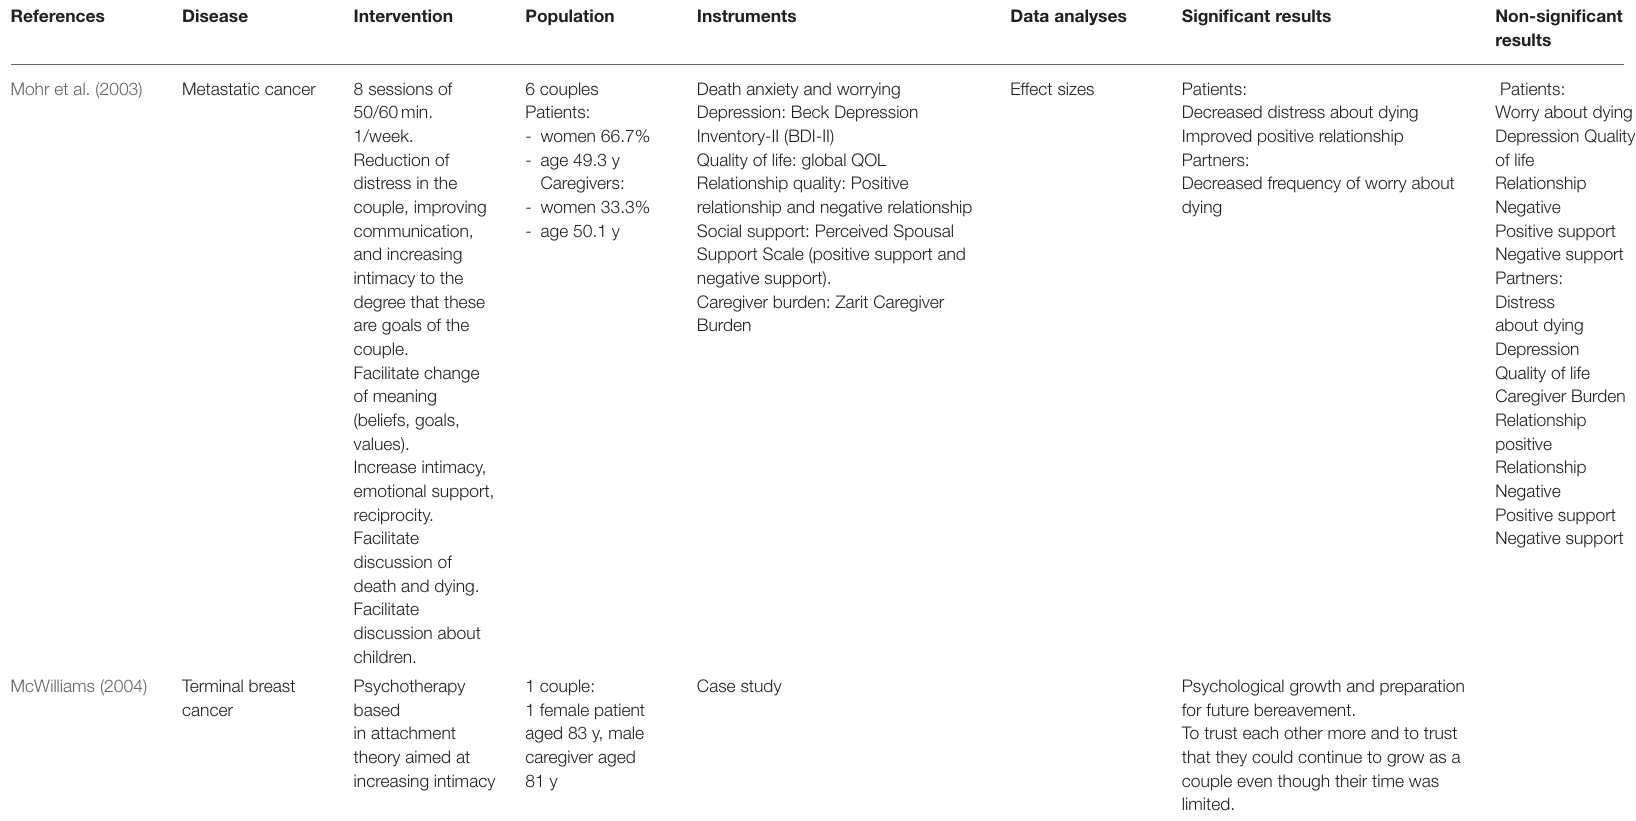
TABLE 3 | Descriptive table of interventions focused on the patient-life partner dyad faced with advanced